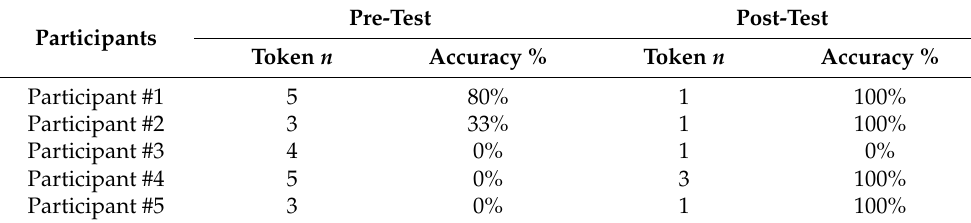
Table 7. Results of the usage of the particle tan in the open-ended questions.